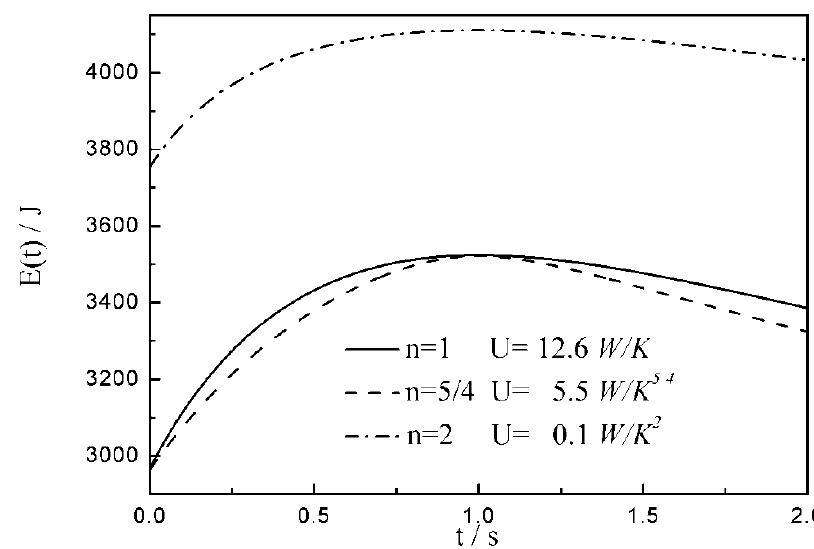
Figure 10. Optimal internal energy versus time with different heat transfer laws.